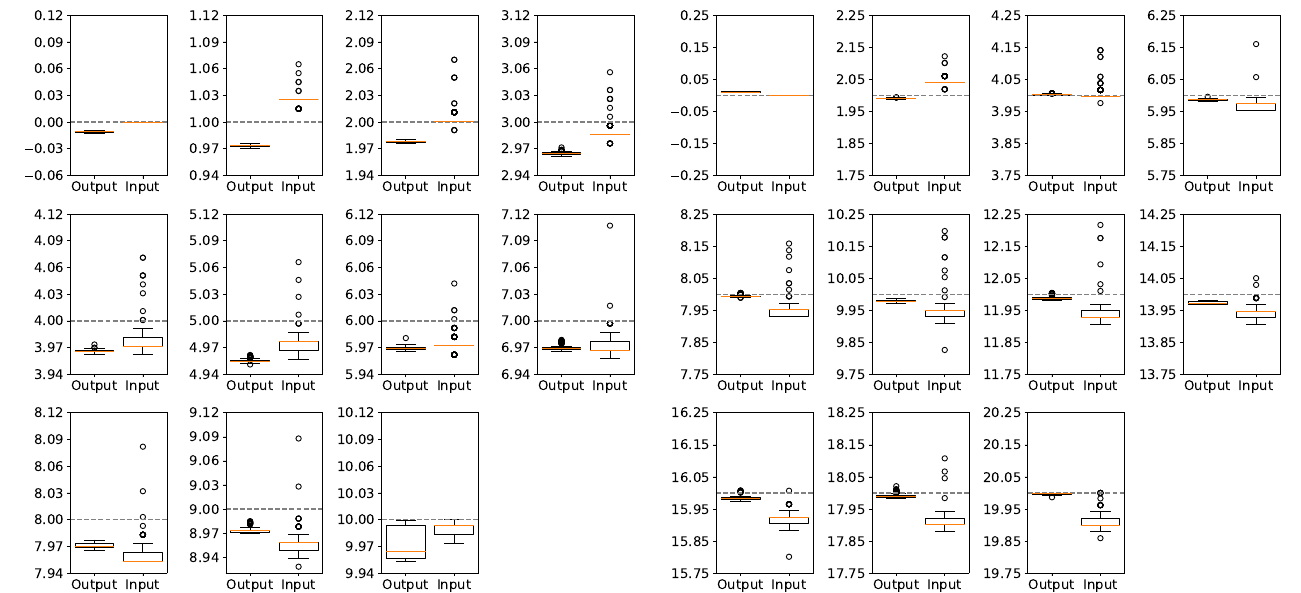
Figure 7. Results of the AGW performance test. From 0–10Von the left side and from 0–20mAon the right side. The related setpoints are displayed by the gray dashed